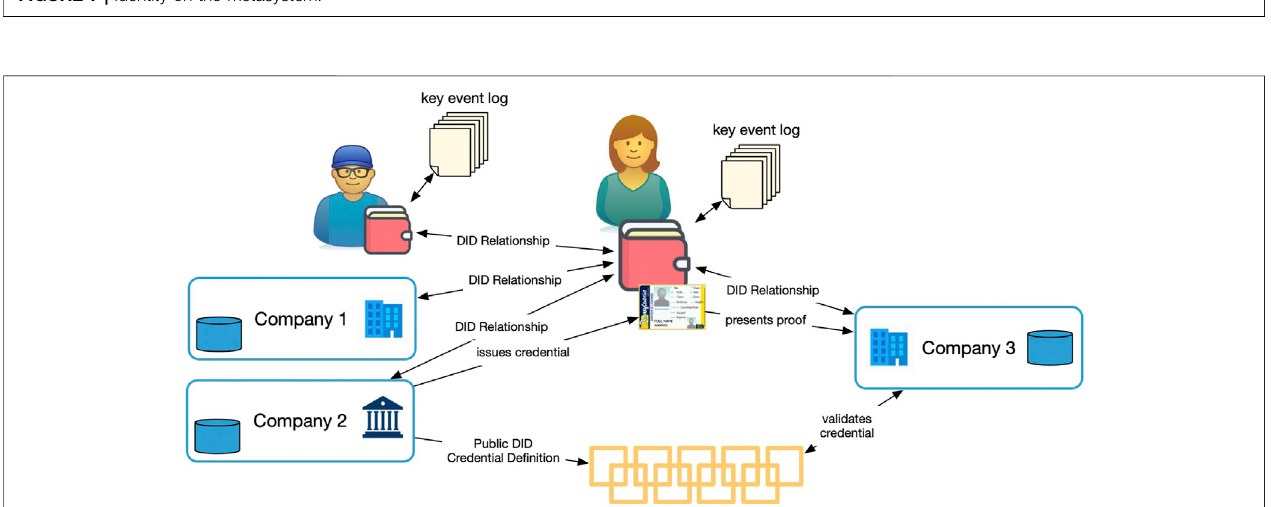
FIGURE 7 | Identity on the metasystem.